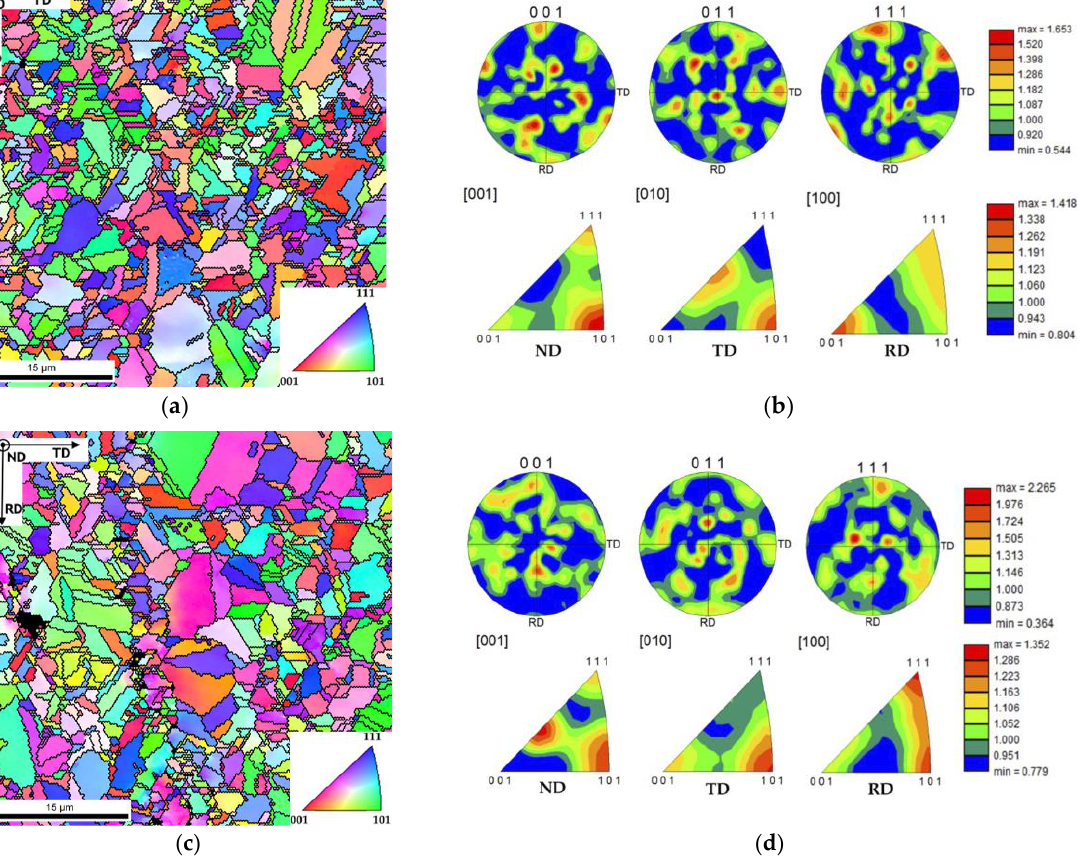
Figure 10. ( a , c ) IPF maps and ( b , d ) [001], [010] and [100] IPFs and {001}, {011} and {111} PFs of Cu and Cu/CNT nanocomposites, respectively.